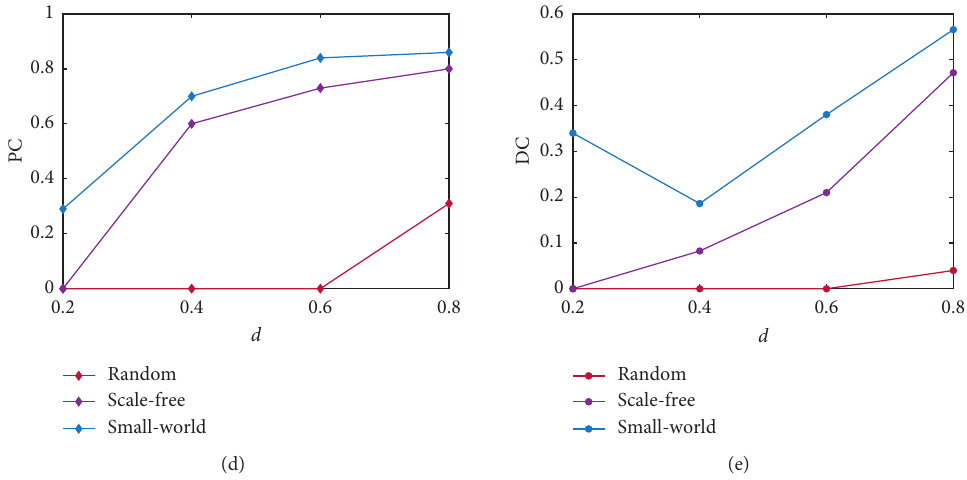
Figure 8: Evolution results of the diverse interbank networks under different d .